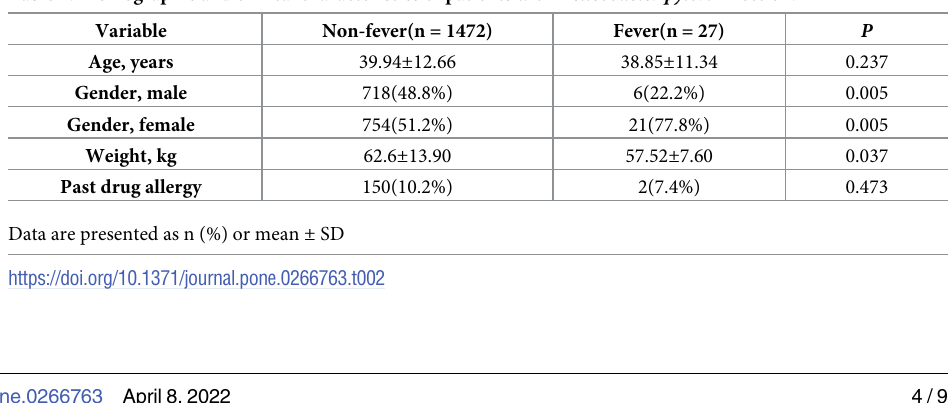
Table 2. Demographic and clinical characteristics of patients with Helicobacter pylori infection.